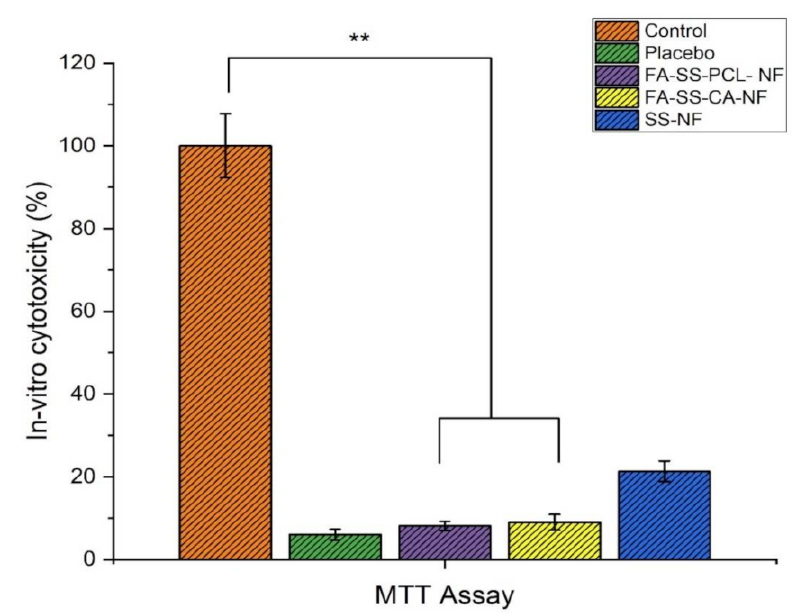
Figure 10. Quantitative assay of in vitro cytotoxicity of all formulations by MTT on HaCaT cells (mean ± S.D). ** Significant differences between control and the